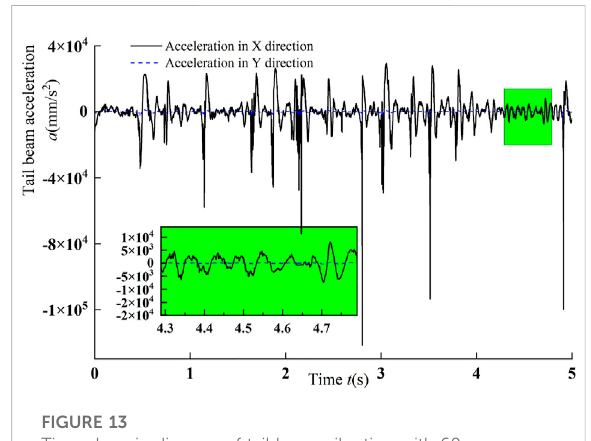
FIGURE 13 Time-domain diagram of tail beam vibration with 60 mm particle